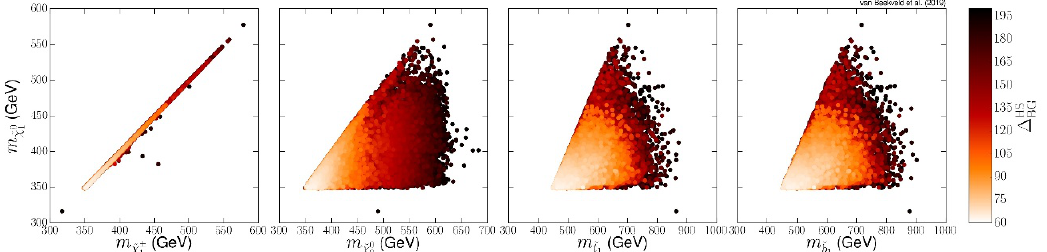
Figure 12 . The masses of ~ (cid:31) (cid:6) by the color, and we only show spectra with (cid:1) HS lie on top of those with higher